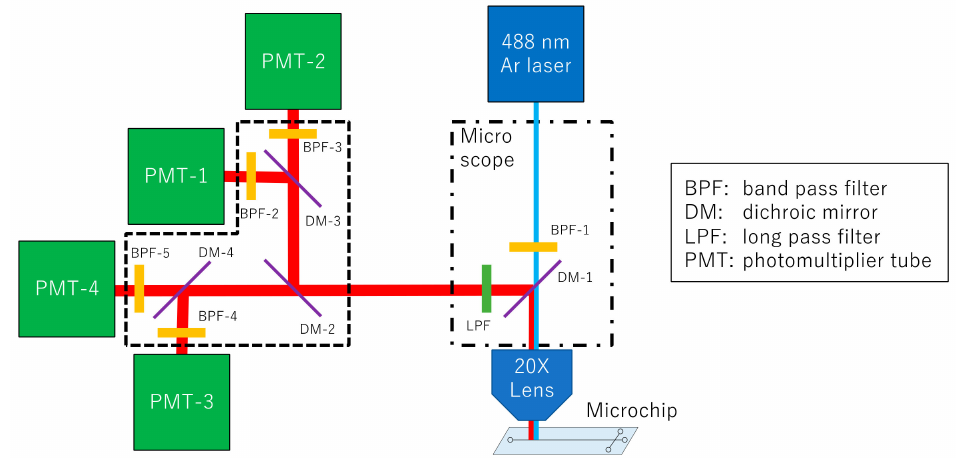
Figure 2. Schematic diagram of the optical system for DNA sequencing. The system consists of a 488 nm laser, a microscope with a 20X objective lens, and four PMTs. Fluorescence is split into four wavelengths using three dichroic mirrors, and detected using four PMTs through each band pass